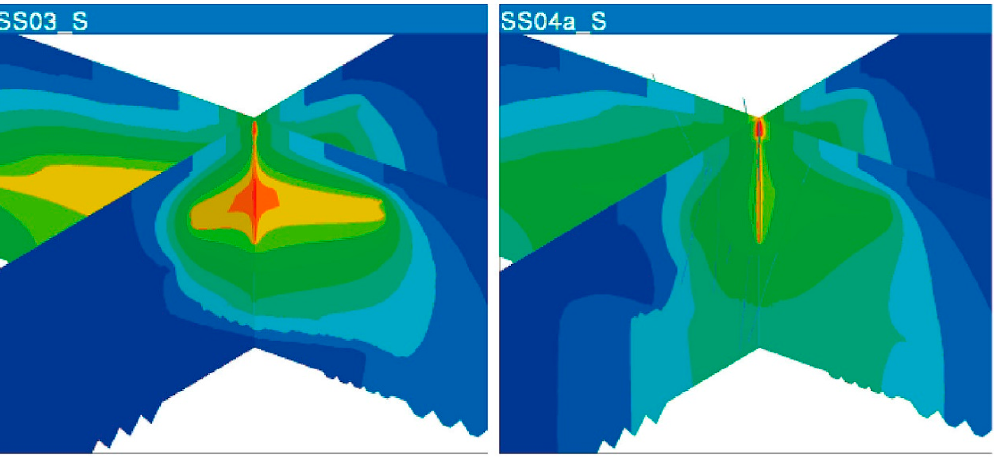
Figure 4. Contoured normalized drawdown for the Posiva/VTT small zone models for case SS03 (no monitoring boreholes) and case SS04a (including monitoring boreholes). Both are uncalibrated